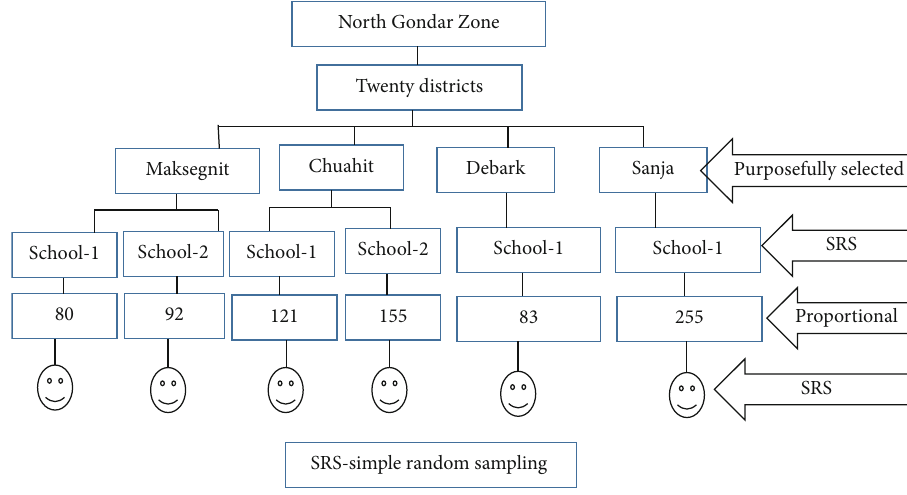
Figure 1: Schematic presentation of sampling technique. Table 1: Sociodemographic, behavioral characteristics of schoolchildren in Northwest Ethiopia, 2018.